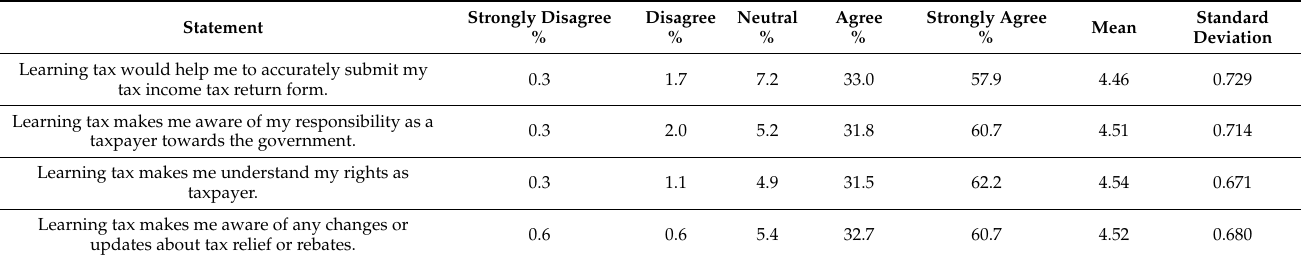
Table 3. Opinion on the importance of tax